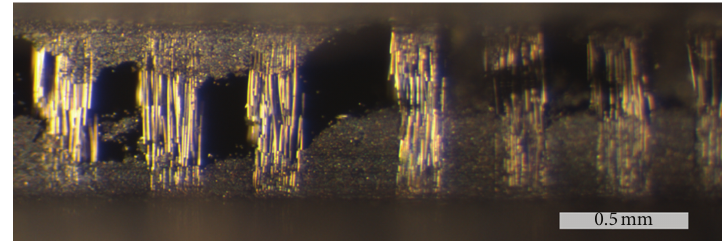
Figure 13: Stereoscope image of the side of a fractured specimen.